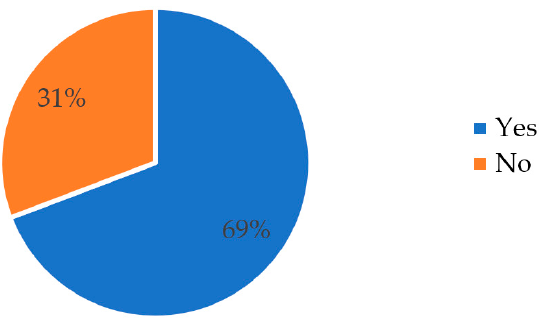
Figure 3. Ratio of the mines where changes were made to the applied mining methods, which indi- cates the process is adjusted to the conditions.